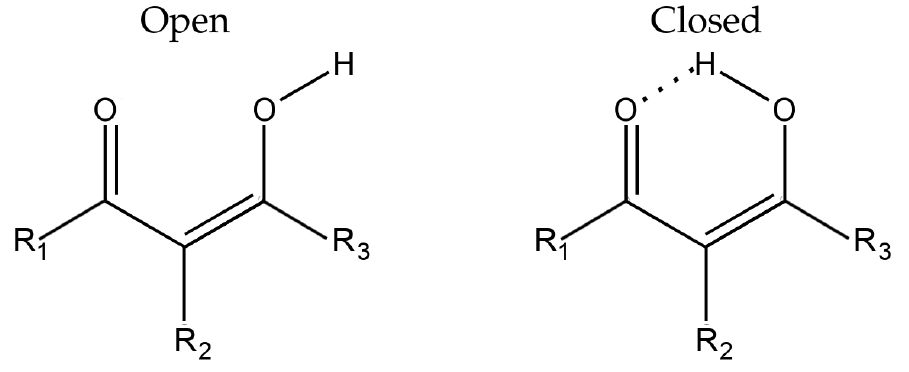
Figure 1. Malondialdehyde structure in its open ( left ) and closed ( right ) conformations. The R n (n = 1, 2, 3) symbols indicate the different positions available for substitution by the − F, − Cl, − Br, − CF , − OCH , − N(CH ) , − NHCOCH , and − NO 3 3 3 2 3 2